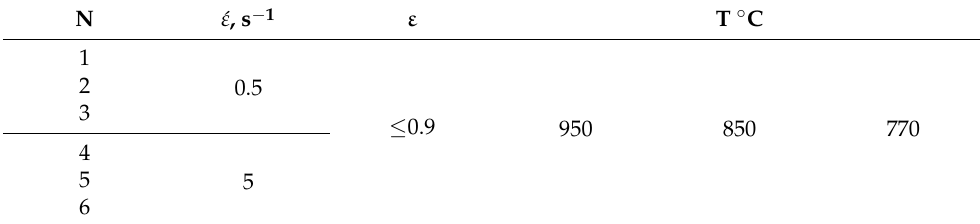
Table 1. Edge conditions for determining the flow stress σ p of the M5 alloy on the Gleeble 3800 plastometer under hot forging conditions. N ´ ε , s − 1 ε T ◦ C 1 7702 0.5 3 ≤ 0.9 950 850 4 55